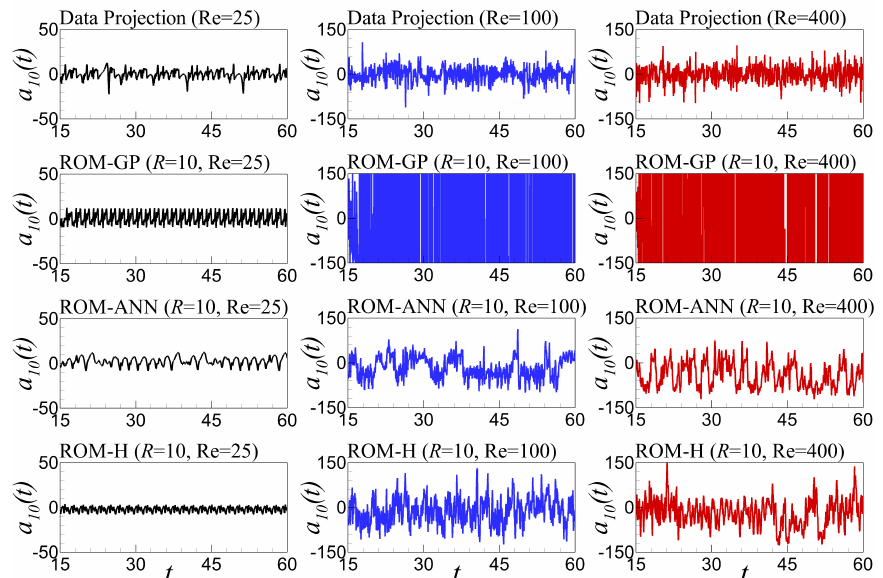
Figure 13. Time series evolution of the first modal coefficient, a 1 ( t ) , between t = 15 and t = 60 for FOM projection and different ROM approaches (ROM-GP, ROM-ANN, and ROM-H) with varying Re (Re = 25,100,400) and POD modes ( R = 10,20,30,40).